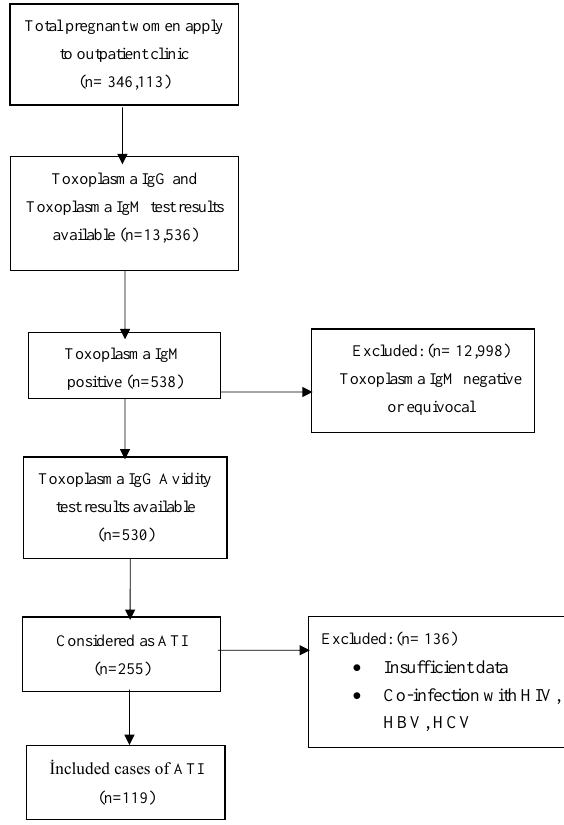
Figure 1. Flow chart of the patient selection.